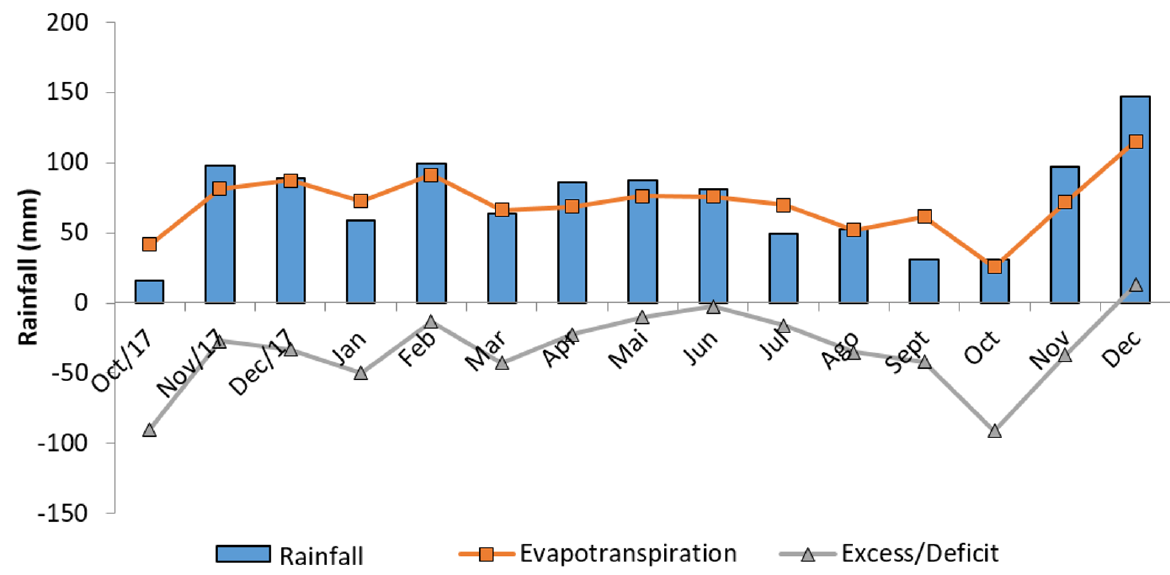
Figure 2. Water balance from January to December 2018, in the municipality of Jequié. Source: CPTEC INPE: http:// www.cptec.inpe.Br/proclima2/balanço_hidrico/balancohidrico. shtml. Accessed on